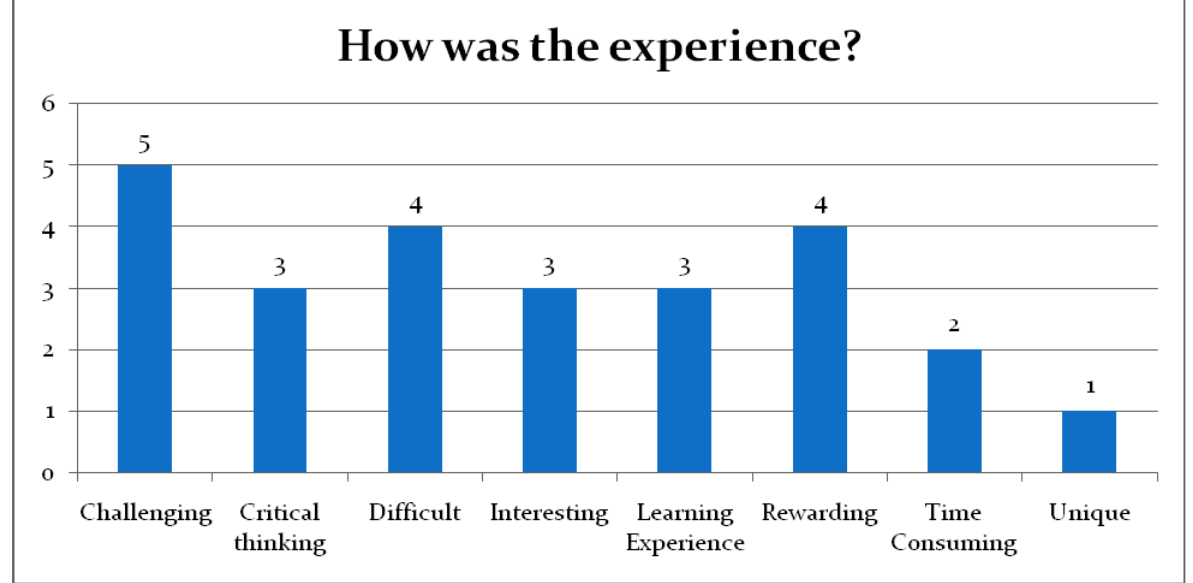
Figure 2 . Experience of IEN RNS in completion of